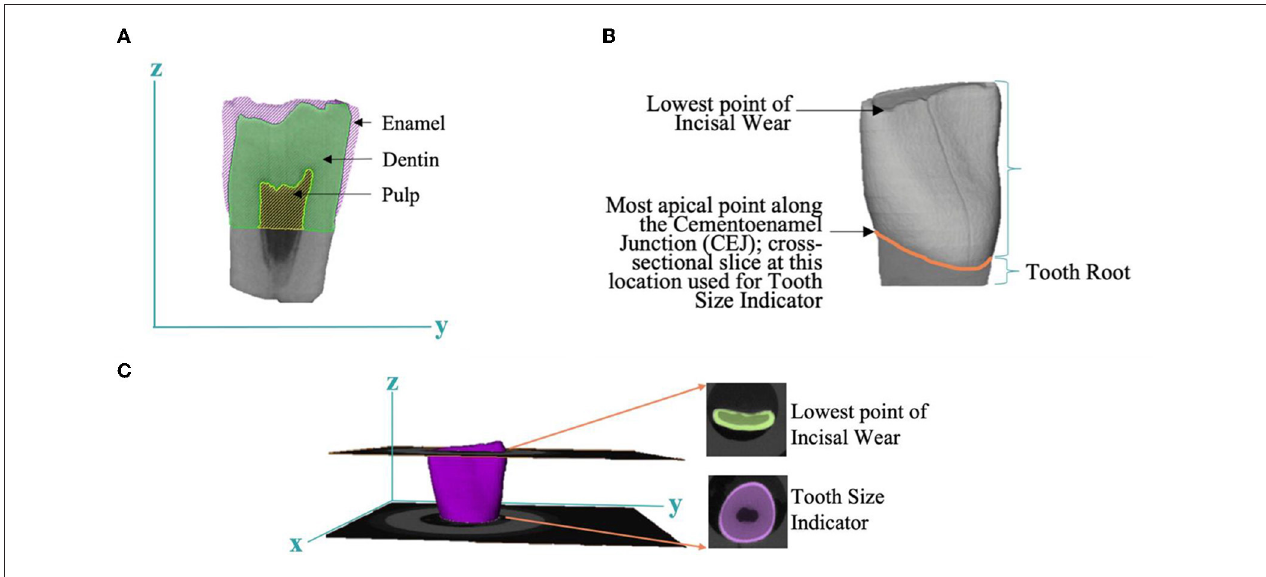
FIGURE 1 | Tooth-based measures derived by micro-CT. (A) A 2D image highlighting the anatomy of the dental compartments: enamel, dentin, and pulp. (B) Estimation of tooth size based on most apical point along the cementoenamel junction (CEJ). (C) Evaluation of bruxing factor, or tooth wear, derived from lowest point of incisal wear and tooth size